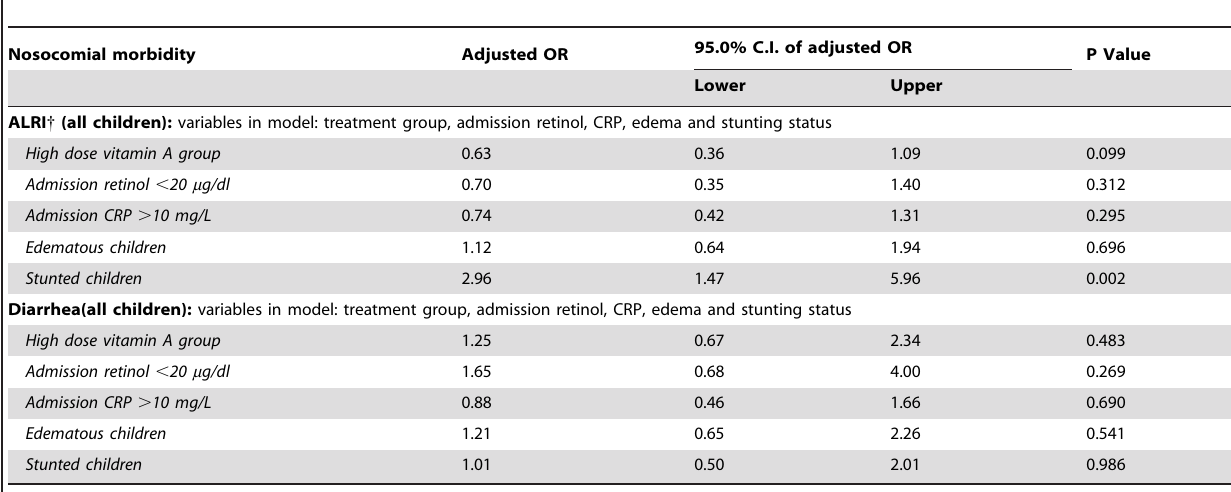
Table 5. Results of exploratory analyses by logistic regression on occurrence of nosocomial morbidities after adjusting the other